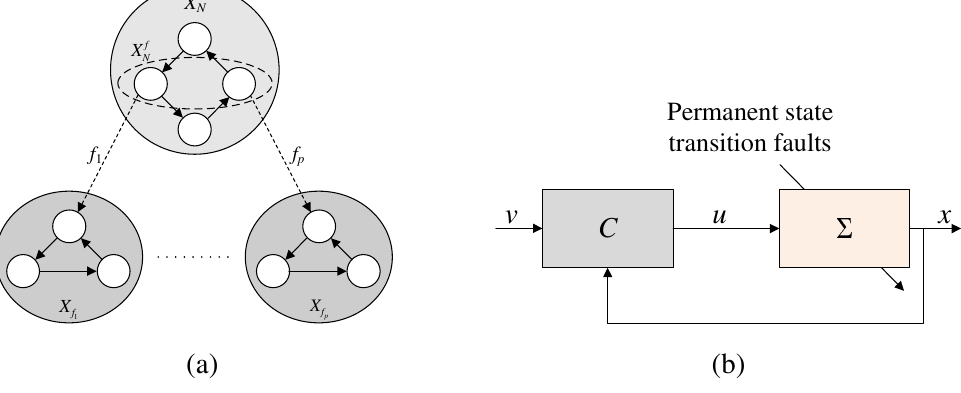
Figure 6. ( a ) Permanent state faults and ( b ) corrective control system with permanent state transi- tion